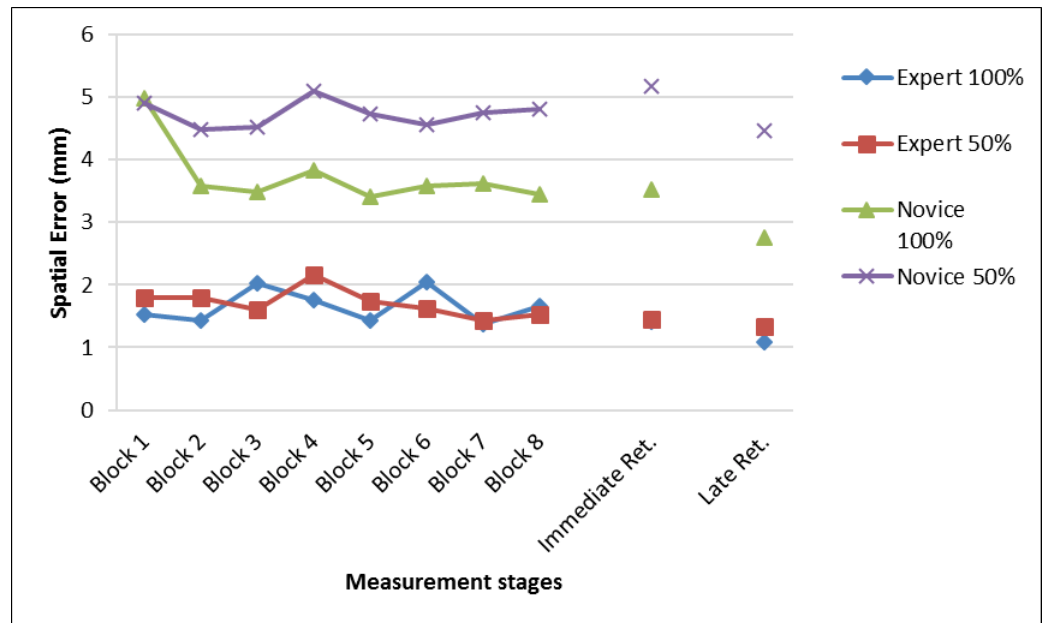
Figure 2. Mean of spatial error of complex task at different measurement